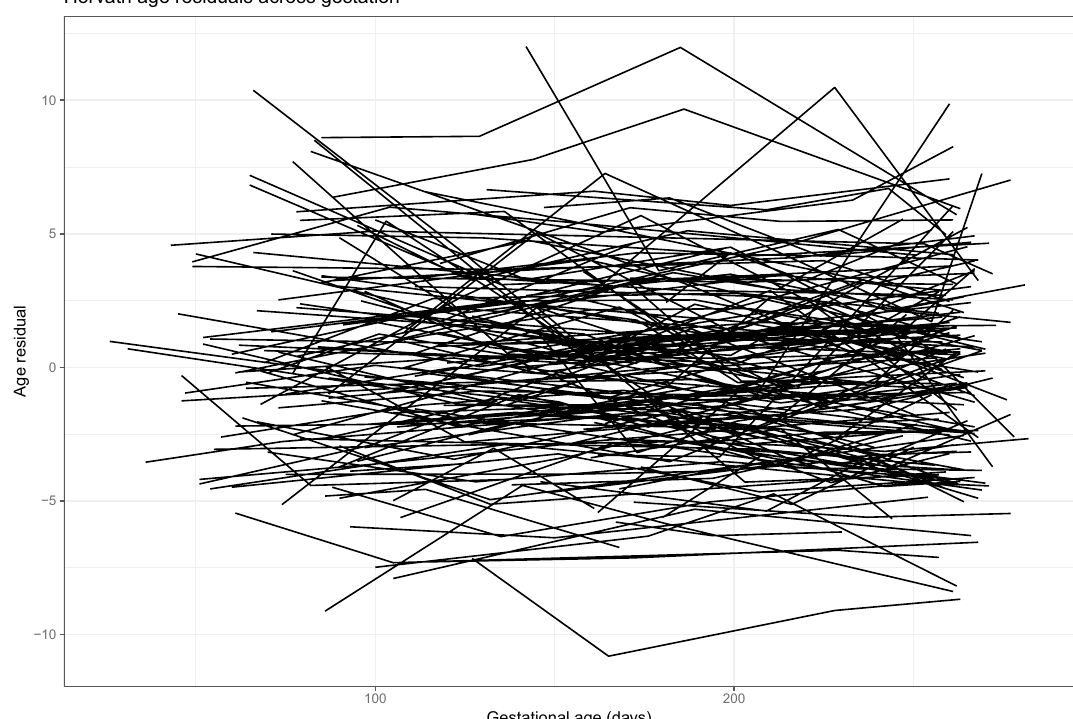
Figure 2. Biological age residuals across pregnancy. Residualized biological age scores were calculated for the entire PREG sample by regressing biological age estimates on to chronological age. Each line represents an unique individual, and each point indicates an individual assessment (i.e., study